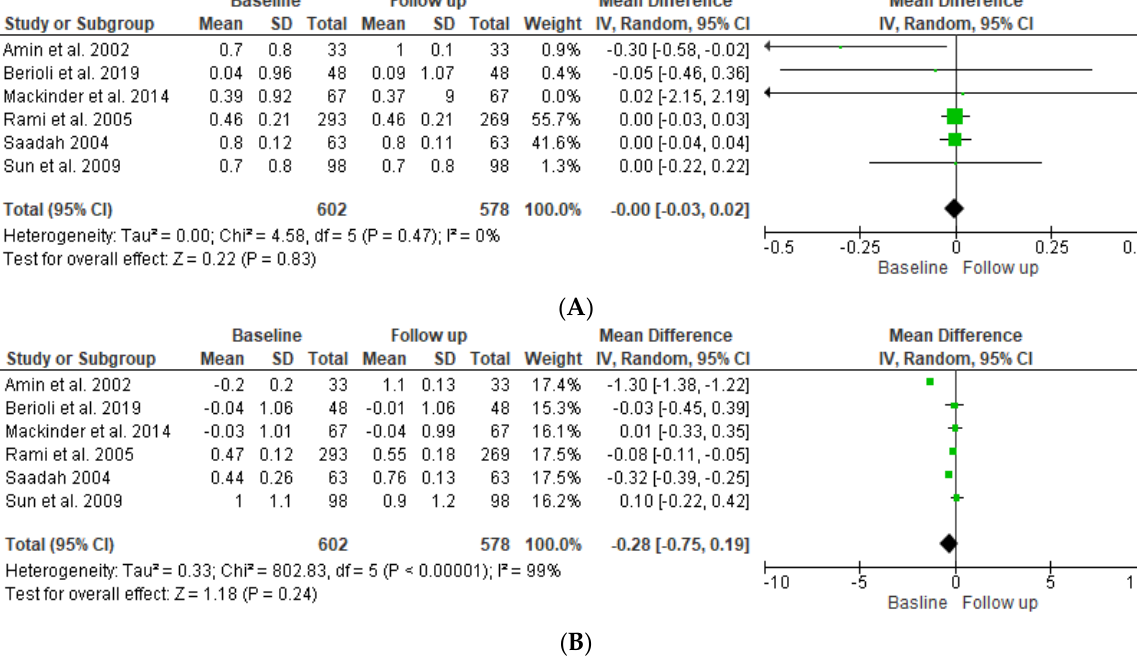
Figure 2. Forest plot showing standard deviation scores (SDSs) of the BMI for DM patients ( A ) and DM and CD patients ( B ) at baseline compared to follow-up.